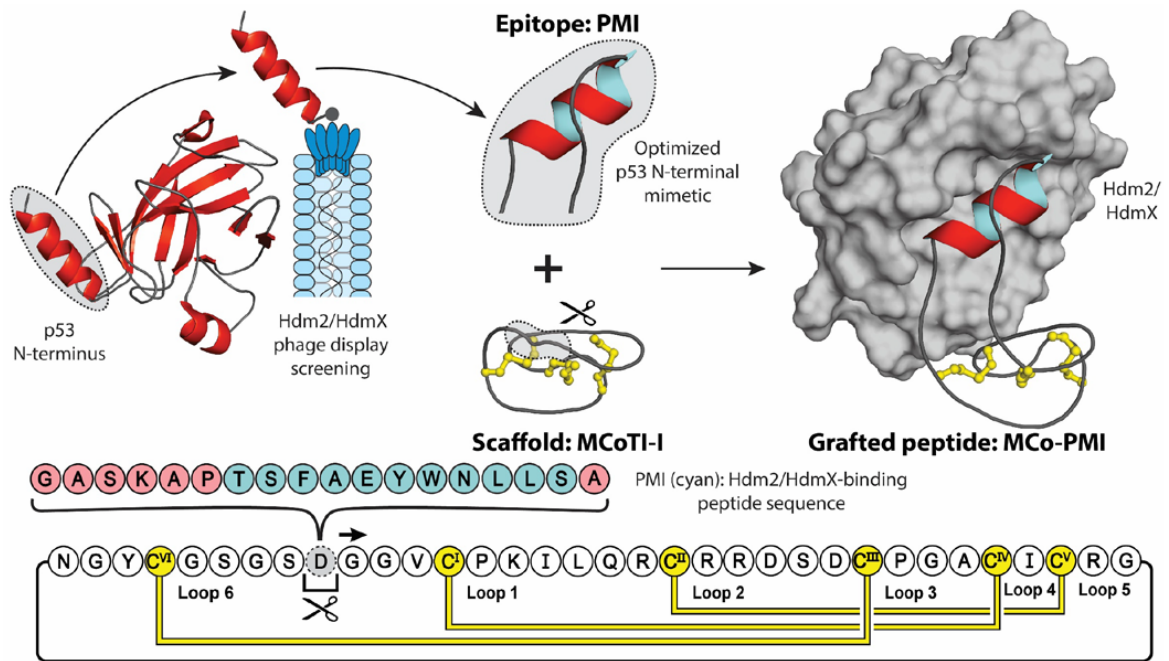
Figure 2 . Molecular grafting onto a cyclic peptide scaffold to stabilize a biologically active peptide sequence. In a recent study, the MCoTI-I scaffold was used to stabilize the helical Hdm2/HdmX- binding peptide PMI (cyan), with an apamin-derived linker (pink), for the treatment of cancer. The PMI epitope was derived from the N-terminal domain of p53 and optimized through phage display screening. When grafted onto the MCoTI-I framework, the resulting grafted peptide MCo-PMI dis- played high serum stability and potent intracellular activity.